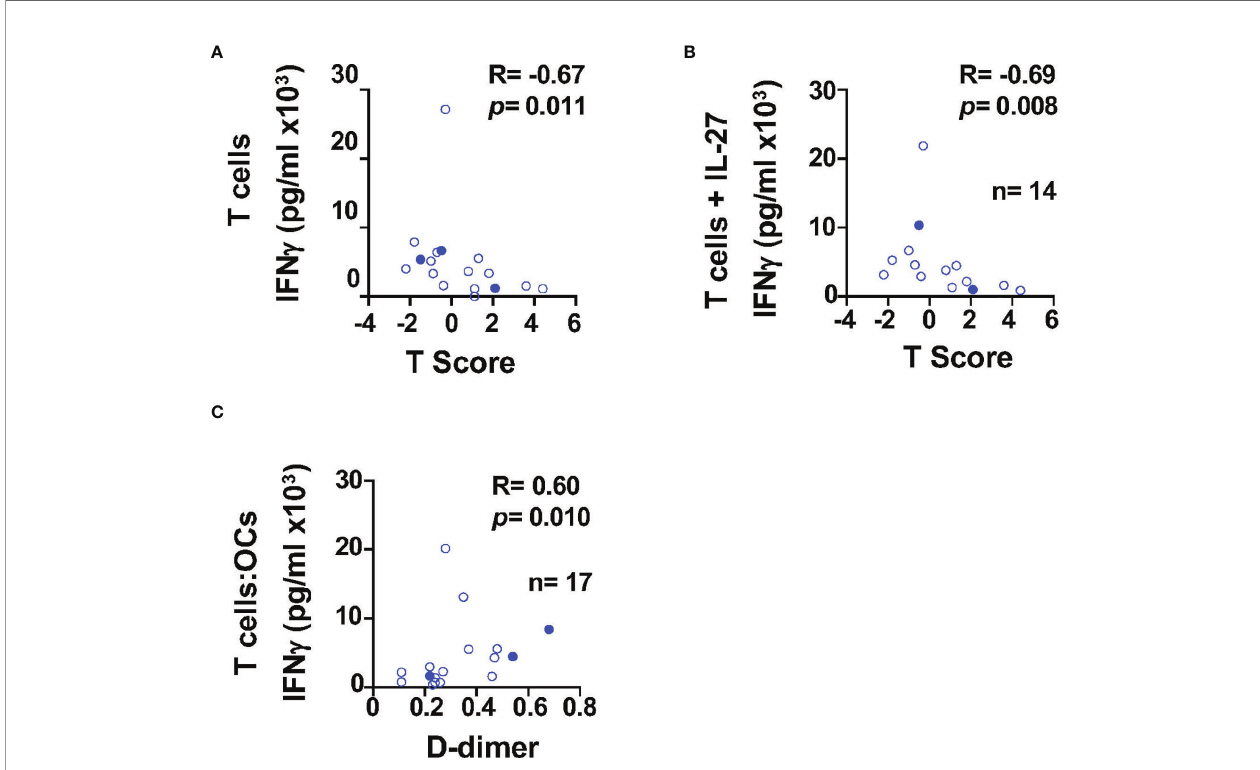
FIGURE 3 | IFN g secretion is associated with BMD in PWH. Relationship between IFN g secretion and BMD in T cells cultured: (A) alone (n=17), (B) in presence of IL-27 (n = 14). (C) Relationship between IFN g secretion in the T cell:OCs cocultures (n = 17) and D-dimer. Correlations were performed using nonparametric Spearman correlation and p-value ≤ 0.01 was considered signi fi